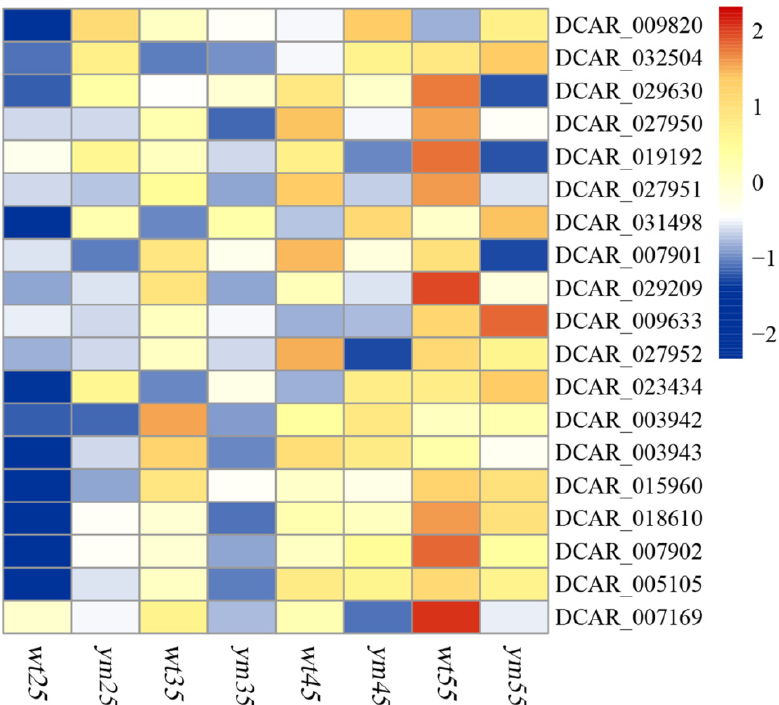
Figure 5. Heatmap of the 19 photosynthesis-related genes between wt and ym during the accumula- tion of carotenoids. Table 1. Correlation between the expression levels of 19 photosynthesis-related genes and carote- noid content in different carrots.